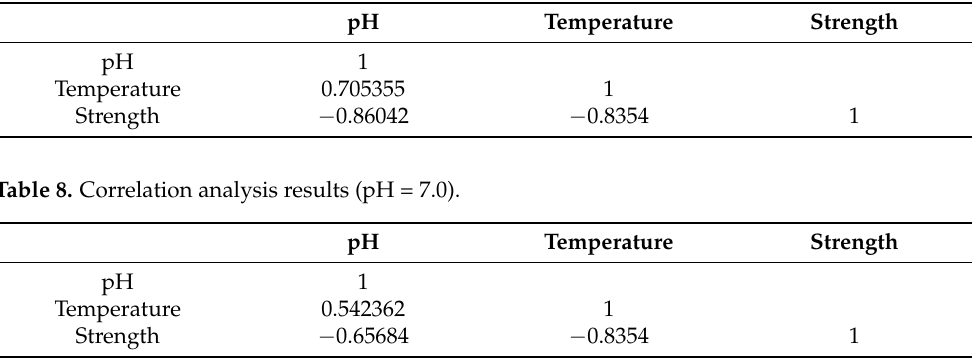
Table 7. Correlation analysis results (pH = 4.0).